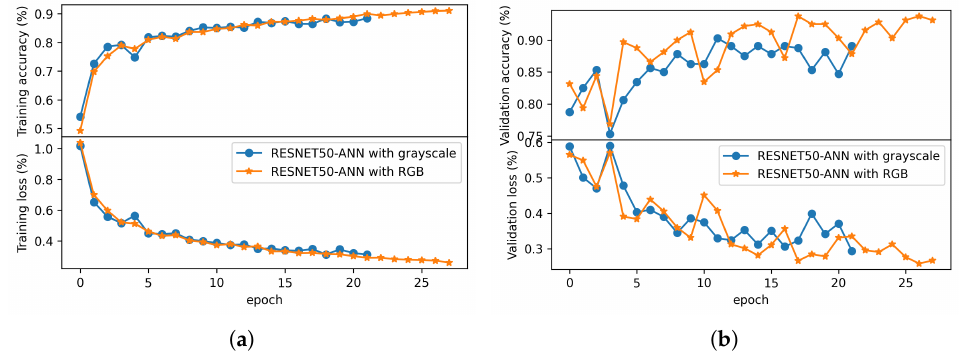
Figure 8. Comparison of ( a ) training and ( b ) validation of ResNet50-ANN models trained by RGB and greyscale dataset.